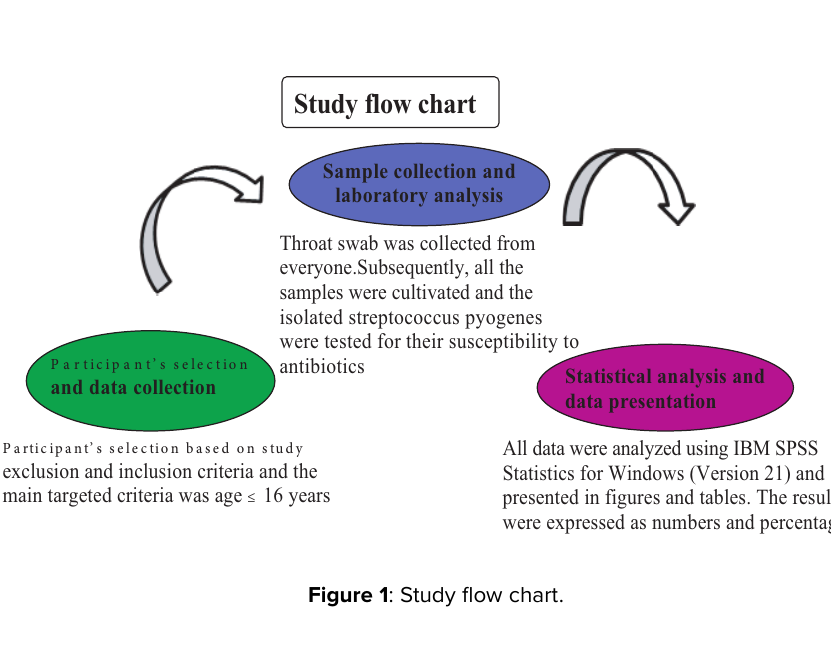
Figure 1 : Study flow